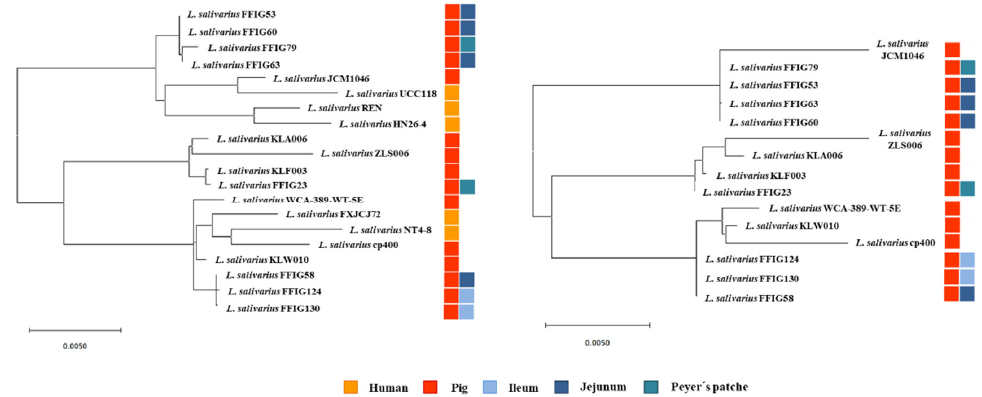
Figure 2. Molecular phylogenetic analysis by Maximum Likelihood method of Ligilactobacillus salivarius strains isolated from the intestinal mucosa of wakame-fed pigs. The phylogenetic trees were constructed based on the MLST analysis by using the genes parB , rpsB , pheS , nrdB , groEL , and ftsQ present the genomes of FFIG strains, as well as in L. salivarius strains with available public genomes.